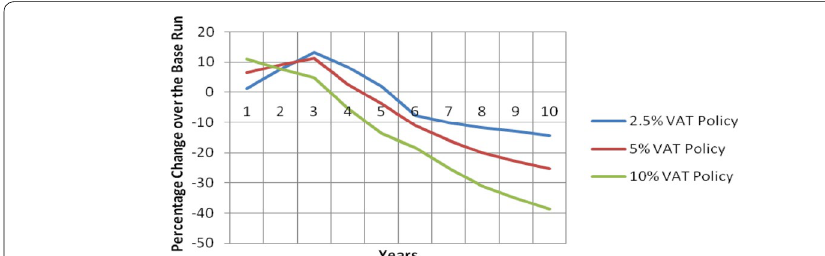
Fig. 12 Percentage changes in household real expenditure